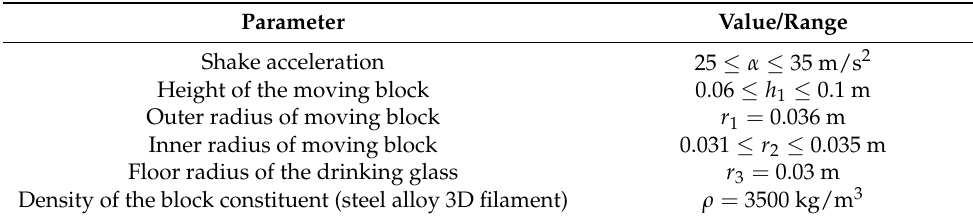
Table 1. Mechanical System Parameters.